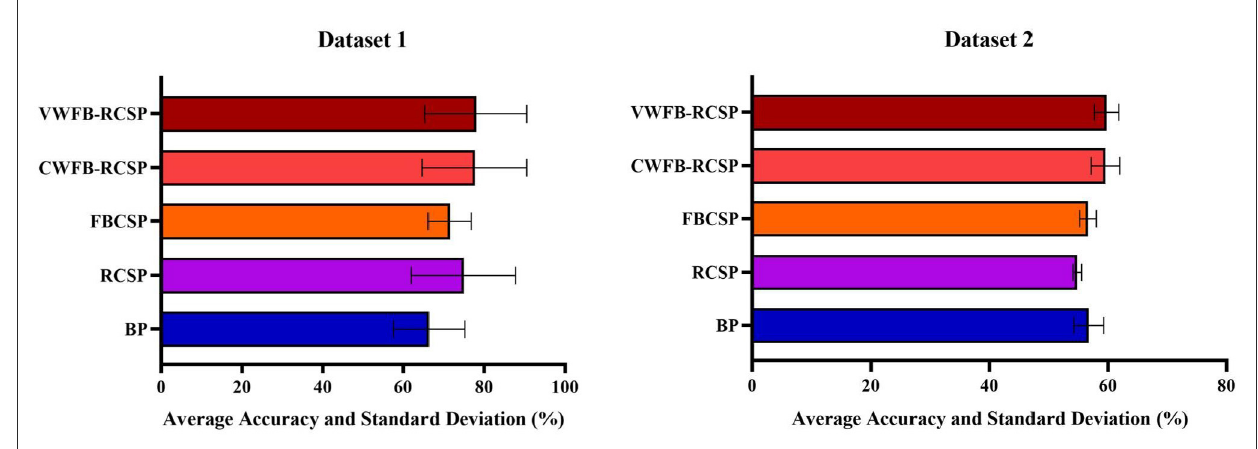
FIGURE5 Average classification accuracy and standard deviation of Dataset 2 under different methods.